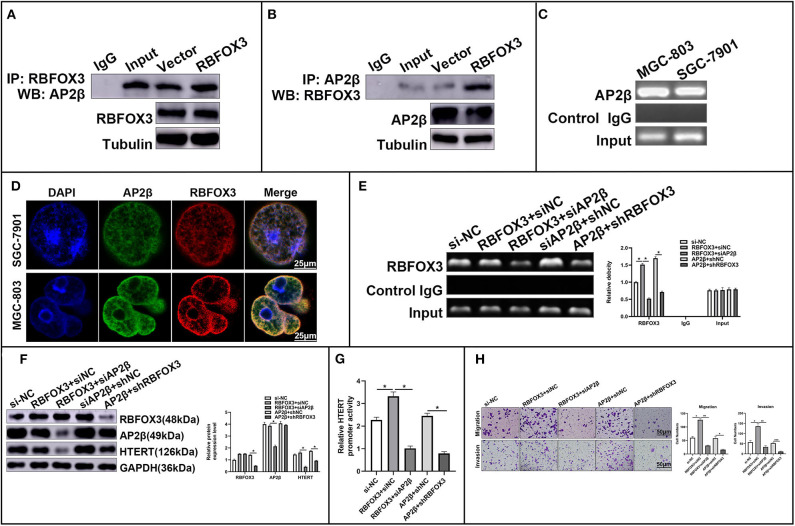
RBFOX3 interacted with AP-2β and modulated the expression of HTERT. (A,B) We transfected SGC-7901 cells with RBFOX3 overexpression or empty vector. CoIP analysis was used to detect the interaction between RBFOX3 and AP-2β. (C) We performed the chromatin immunoprecipitation (ChIP) assays using the antibody against AP-2β. We separated the PCR products of the HTERT promoter (−378 to −157) on 2% agarose gels. (D) We cultured the SGC-7901 as well as the MGC-803 cells grown on chamber slides for 24 h and examined the subcellular localization and the co-localization of RBFOX3 with AP-2β via confocal microscopy analysis. (E) We performed the ChIP assays using the HTERT promoter primers and the respective RBFOX3 antibodies in SGC-7901 cells transfected with RBFOX3, RBFOX3, and siAP-2β, AP-2β, AP-2β, and shRBFOX3, respectively. (F) The expression of HTERT in SGC-7901 cells transfected with RBFOX3, RBFOX3, and siAP-2β, AP-2β, AP-2β, and shRBFOX3, respectively. (G) Relative HTERT promoter activity in SGC-7901 cells transfected with RBFOX3, RBFOX3, and siAP-2β, AP-2β, AP-2β, and shRBFOX3, respectively. (H) We performed the Transwell invasion assay in SGC-7901 cells transfected with RBFOX3, RBFOX3, and siAP-2β, AP-2β, AP-2β, and shRBFOX3, respectively. *p < 0.05, **p < 0.01.